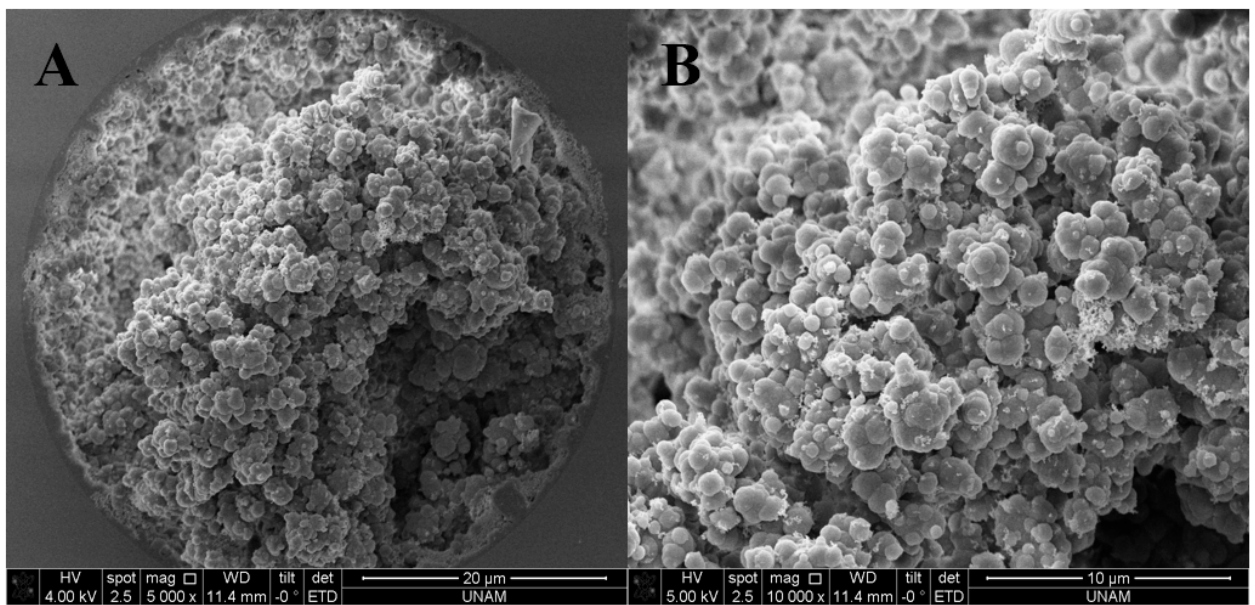
Figure 1. SEM images of the monolithic nano-column with magnification ( A ) ×5000 ( B ) ×10,000 ( A , B ).